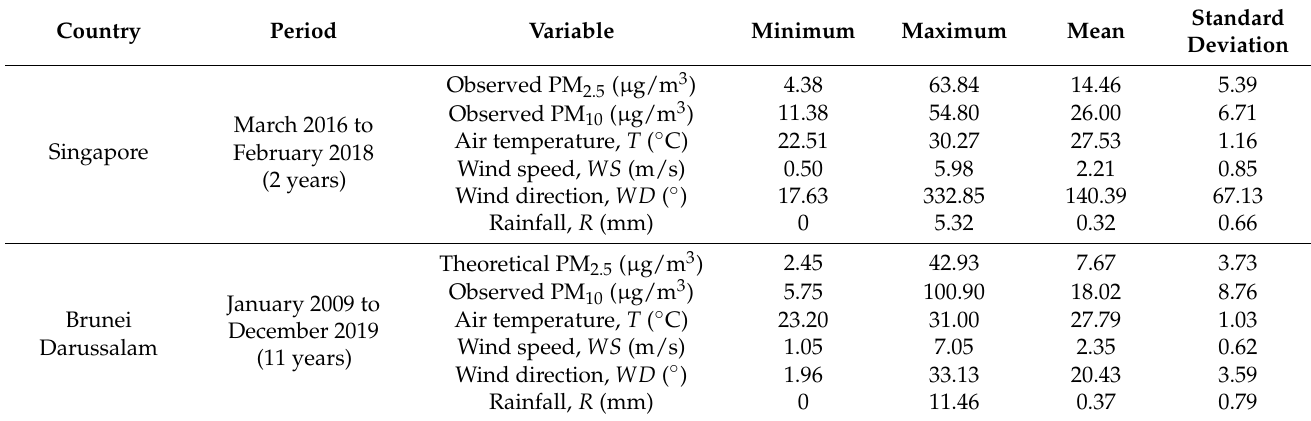
Table 1. Descriptive statistics of measured quantitative variables from all monitoring